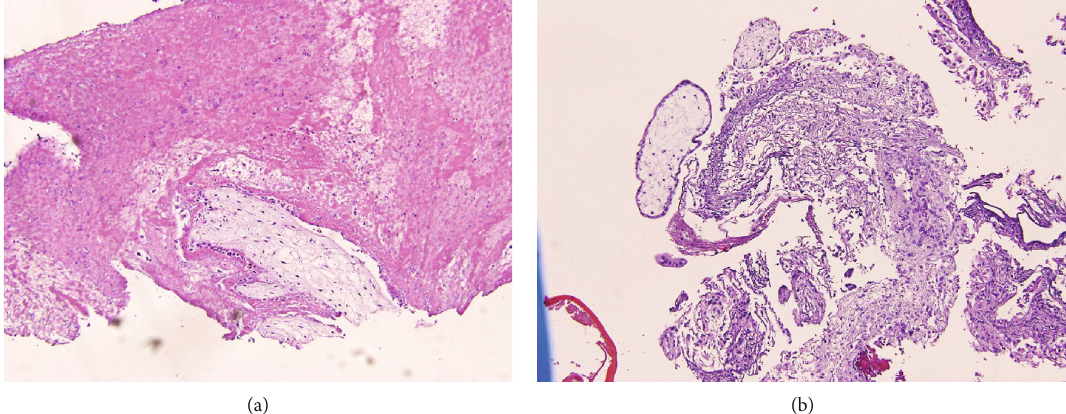
Figure 4: Histopathological view of the left ovarian tissue showing trophoblastic tissue (a) and chorionic villi